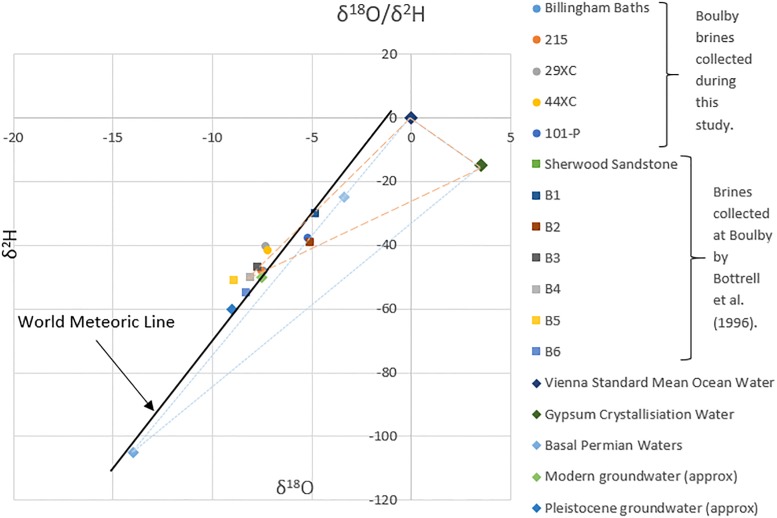
Isotopic data from the brines collected during this study and from Bottrell et al. (1996), plotted with the Global Meteoric Water Line, Standard Mean Ocean Water (SMOW), gypsum crystallization water and other British groundwaters. Two theoretical mixing fields have been added. Both draw a line between ocean water and gypsum crystallization water compositions (since gypsum water of crystallization isotopic composition will be some mixture of the two). The dashed line indicates a mixing of a gypsum crystallization water/ocean water, with meteorically derived groundwater (Sherwood Sandstone waters). The dotted line does the same, except with the isotopically light Permian groundwater taken from Sheppard and Langley (1984). Modern and Pleistocene ground water approximate values are from Darling et al. (2003).